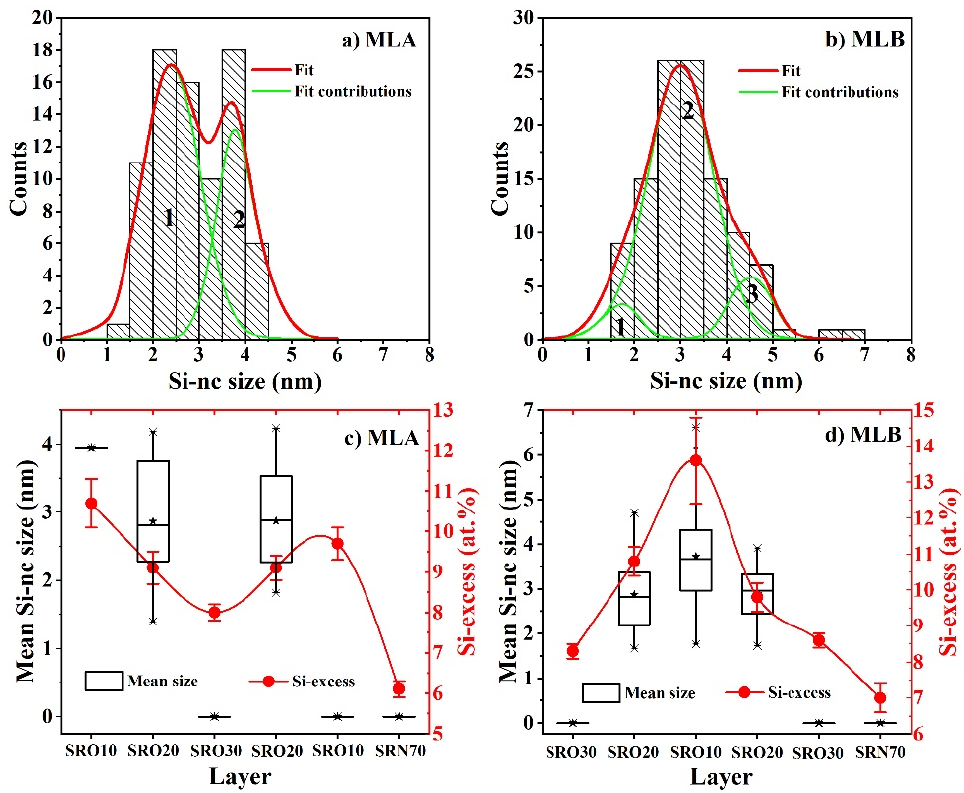
Figure 4. Histograms of Si-ncs sizes in ( a ) MLA and ( b ) MLB and the mean size of the Si-ncs vs. silicon excess of each SRO layer in ( c ) MLA and ( d ) MLB. Numbers in ( a , b ) indicates the Si-ncs size ranges. Table 1. Thickness, excess Si, mean size and density of Si-ncs obtained from XPS and HRTEM micrographs for each of the SRO layers.